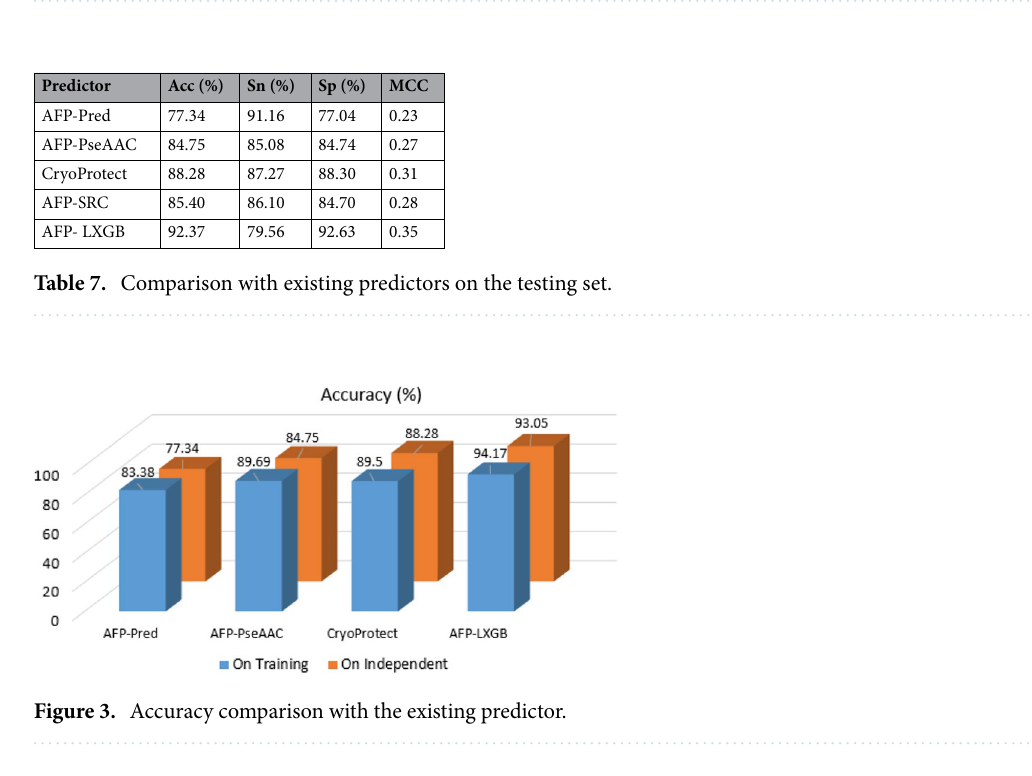
Table 6. Comparison with existing predictors on the training set.